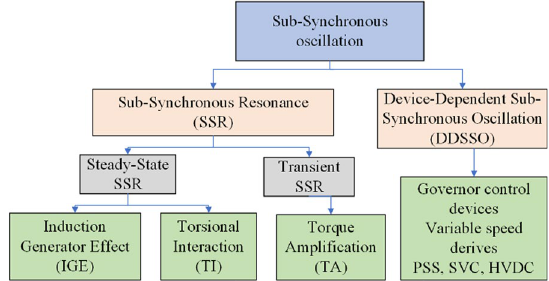
Fig. 2 Classification of SSO by